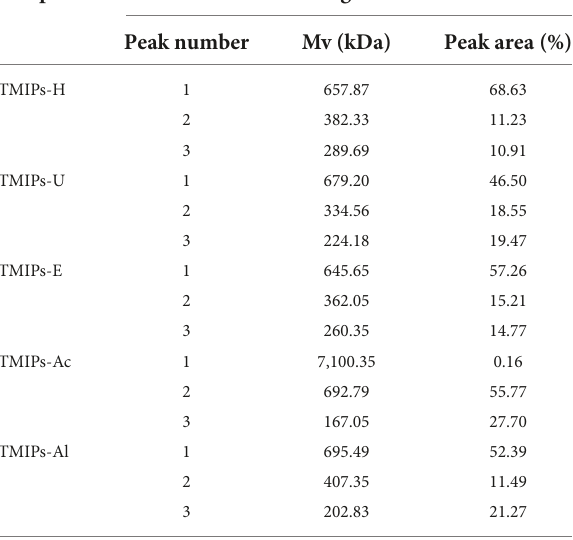
the amounts of protein extracts. TMIPs-E showed the highest uronic acid content ( p < 0.05), indicating that the uronic acid content of polysaccharides was related to the extraction